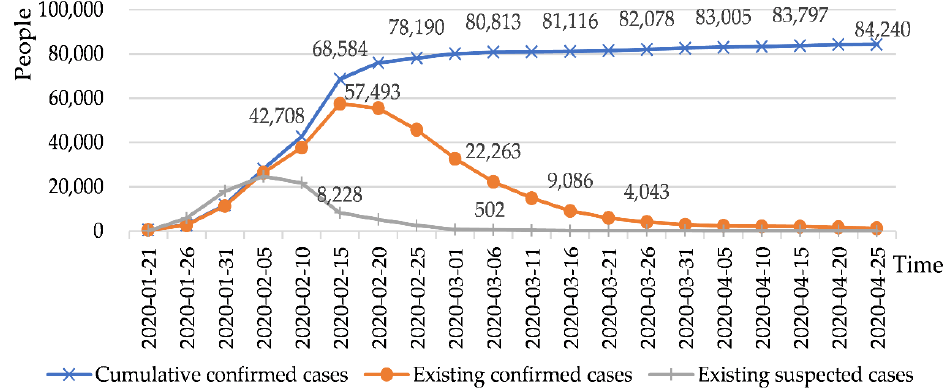
Figure 1. Distribution of COVID-19 cases in China. Note 1. Data was collected from Wind database.